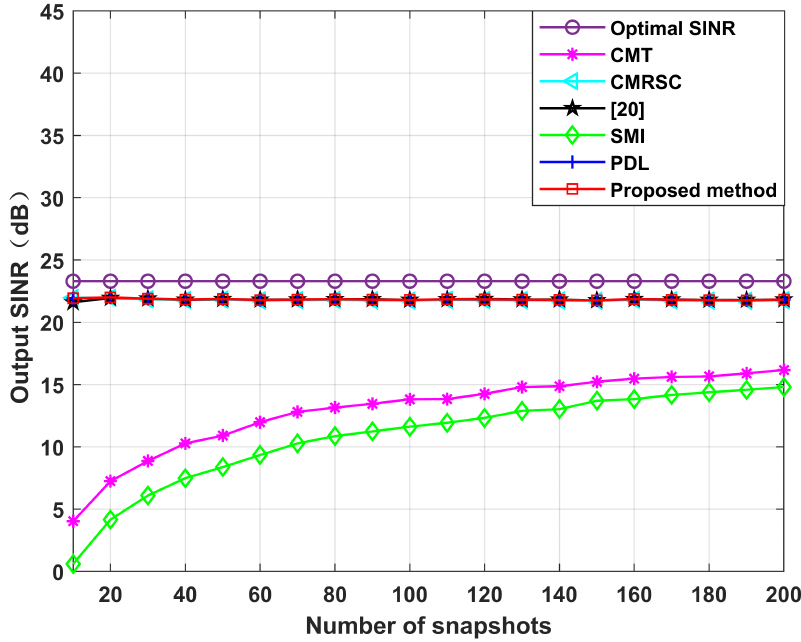
Figure 13. Output SINR under different numbers of snapshots. Simulation 5. Simulation 6. Impact of the SV mismatch on the